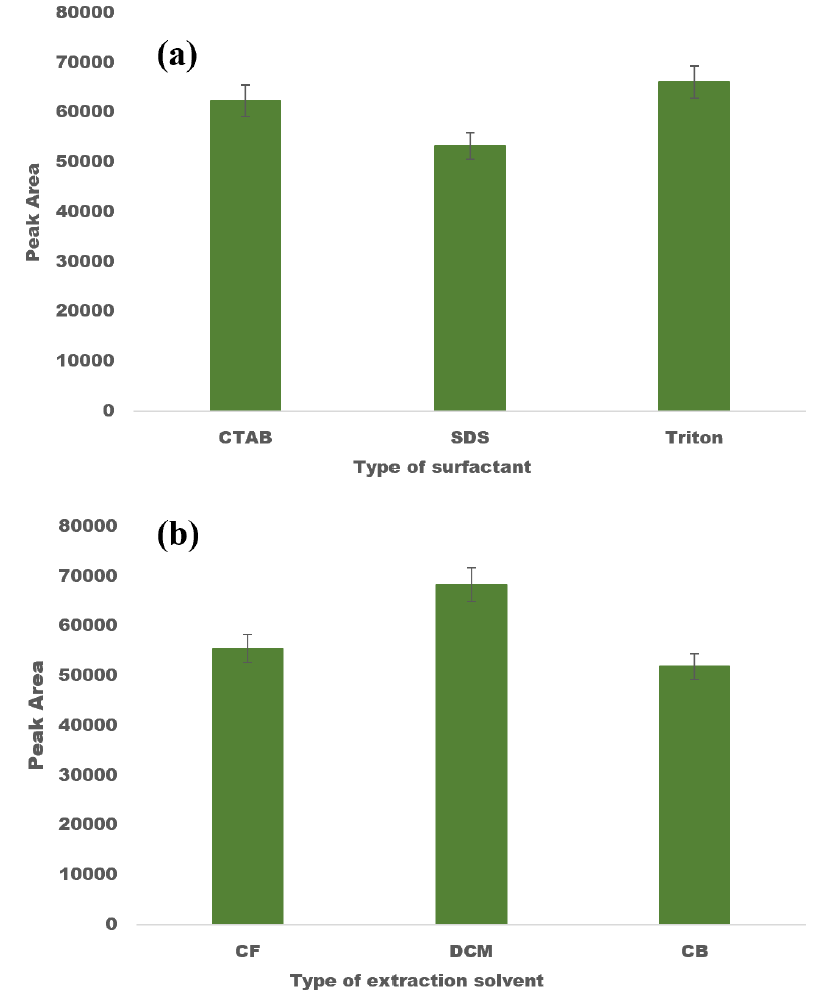
Figure 2. Optimisation of DLLME factors: ( a ) screening of dispersion solvent, and ( b ) screening of extraction solvent.